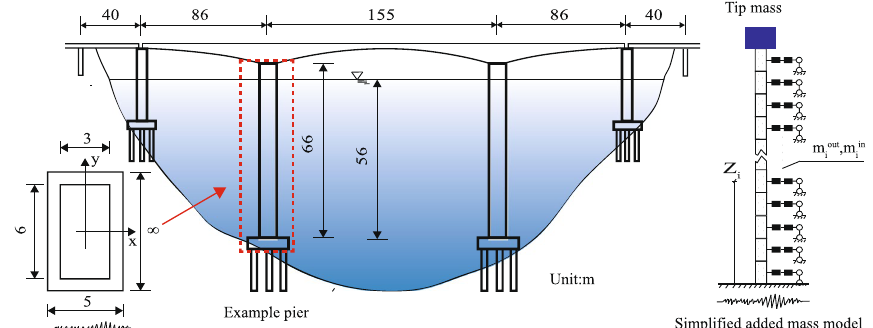
Fig. 18 Example pier and simplified additional mass